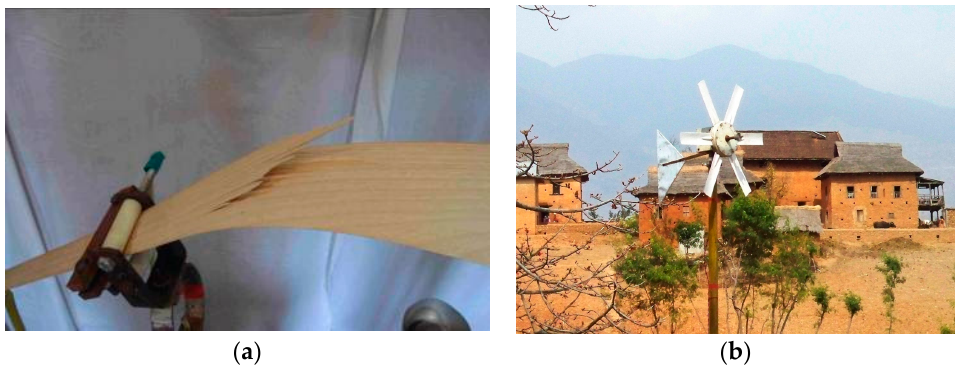
Figure 5. Testing the timber wind turbine blade ( a ) and small wind turbines installed in Nepal ( b ).